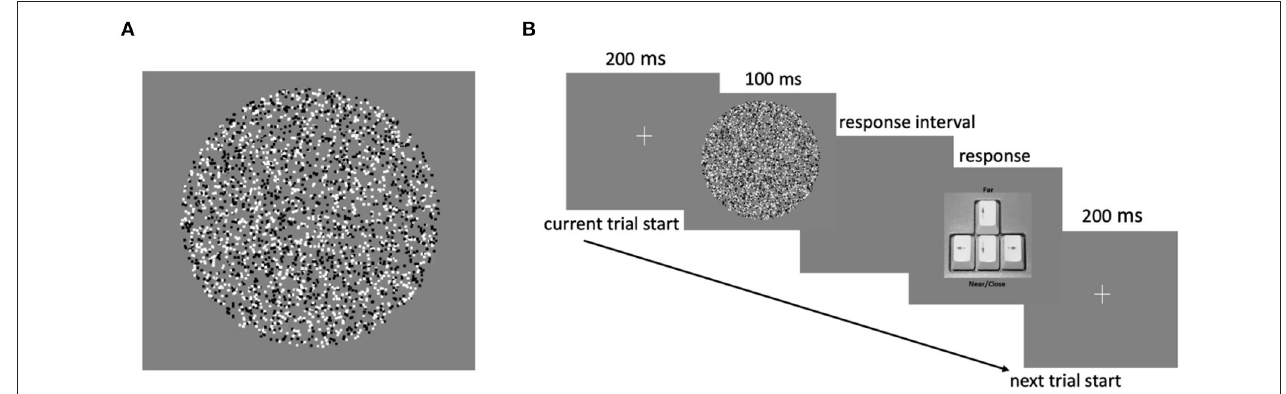
FIGURE 1 | (A) Schematic of an RDS stimulus and (B) trial structure of the experimental